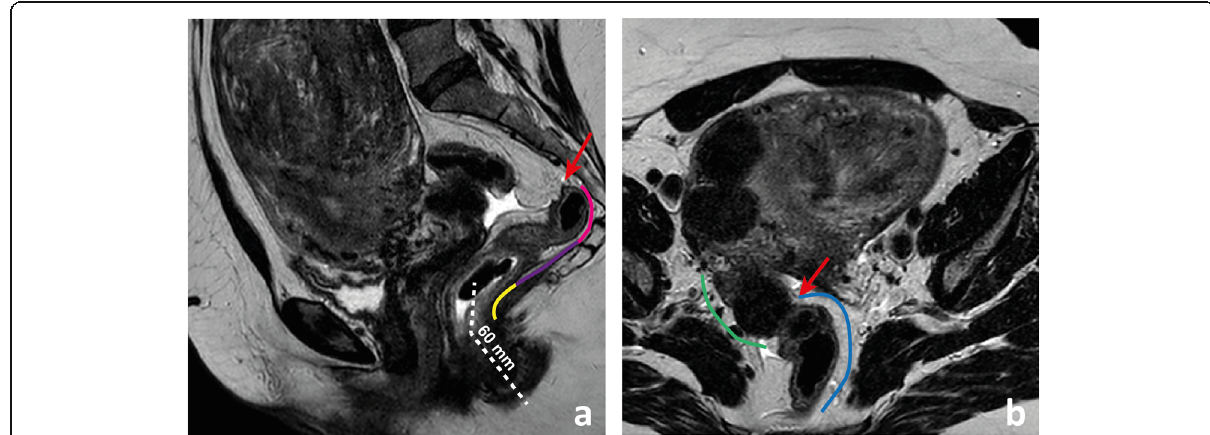
Fig. 2 The upper limit of the rectum corresponds on MR imaging to the point of inflexion between the more vertical rectum and the more horizontal sigmoid “ take off ” (arrow in a ). The sigmoid starts at another more horizontal inflection, better visualised in the (oblique) axial plane (arrow in b ). The low rectum is the segment located < 6 cm above the anal verge and above the anorectal transition (lined in yellow in a ); the mid-rectum is located between the low rectum and the plane of the lowest point of the anterior peritoneal reflection (lined in purple in a ); the high rectum is the segment above it and below the sigmoid “ take-off ” (lined in pink in a ). The sigmoid “ take-off ” or rectosigmoid transition is lined in blue in b , while the actual sigmoid is lined in